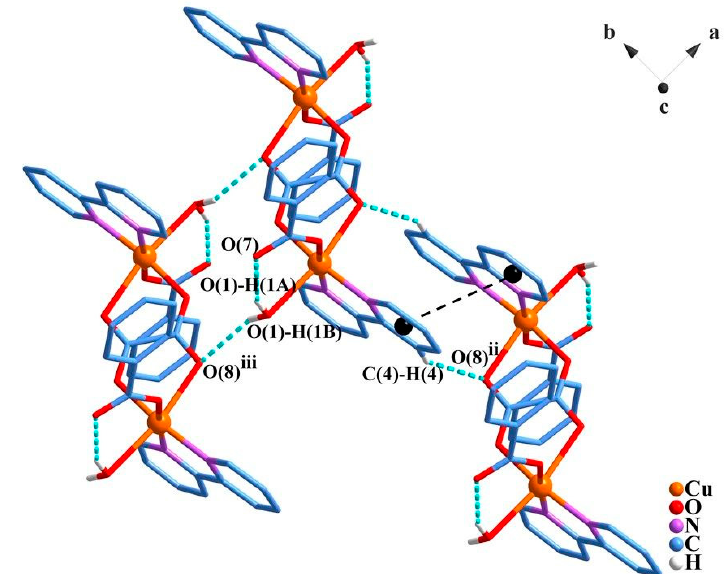
Figure 2. Representation of the hydrogen bonds (dotted blue lines) and π - π stacking (dotted black lines) between the bipy ligands with centroids represented by black spheres. The hydrogen atoms which do not perform hydrogen bonds were omitted for clarity. Symmetry codes: (ii) –x + 1, − y, − z + 1; (iii) x − 1, y, z. The molecules shown were taken into account for the evaluation of the intermolecular magnetic interactions by density functional theory (DFT) methods.